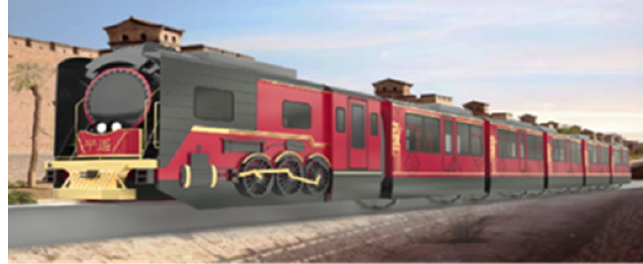
Figure 1. Small train for sightseeing in Pingyao, Shanxi.